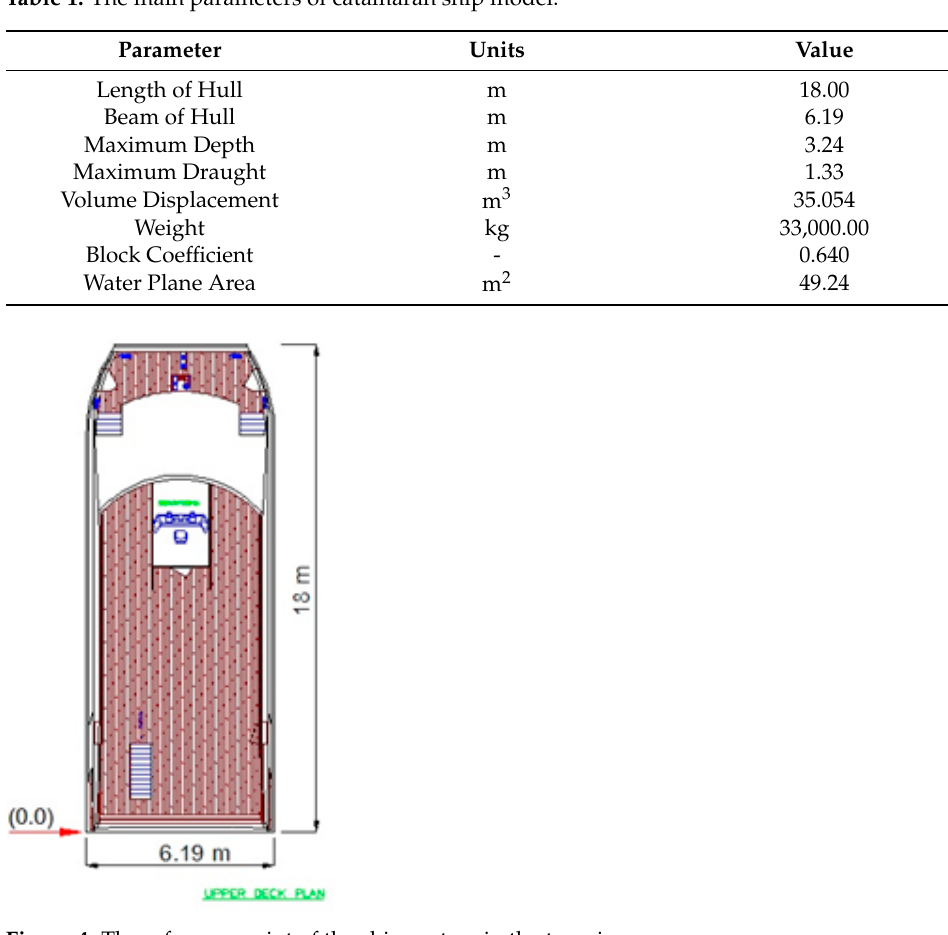
Table 1. The main parameters of catamaran ship model. Figure 3. The flowchart for the proposed method.